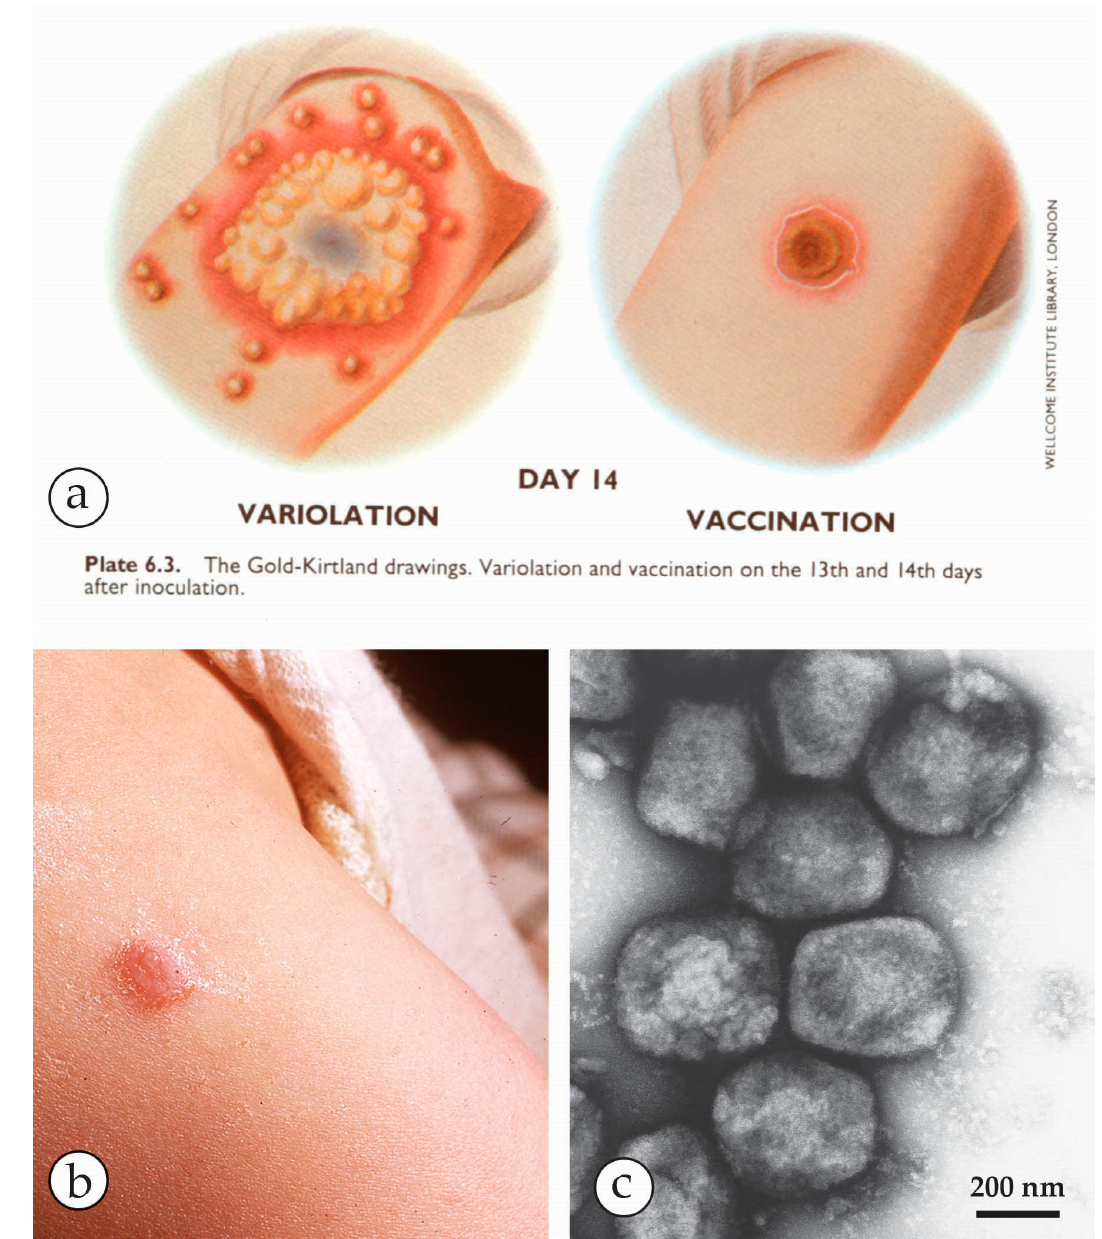
Figure 2. Variolation versus vaccination: ( a ) Variolation, the inoculation of small amounts of live variola lesion fluids was widely used as a protective, though highly risky measure, before Edward Jenner in 1796 established the much less risky vaccination using material from a cowpox lesion [31]. Plate from Fenner et al.: Smallpox and its Eradication [1] with kind permission of WHO, Geneva. ( b ) A routine primary vaccination lesion in a one-year old, containing little vesicle fluid. Photo taken after 1 week. ( c ) Vaccinia virus after NS showing all morphological criteria: size, shape and surface details of OPV. The origin of present day vaccines strains is heterogeneous. For details see [1,16,24,32].